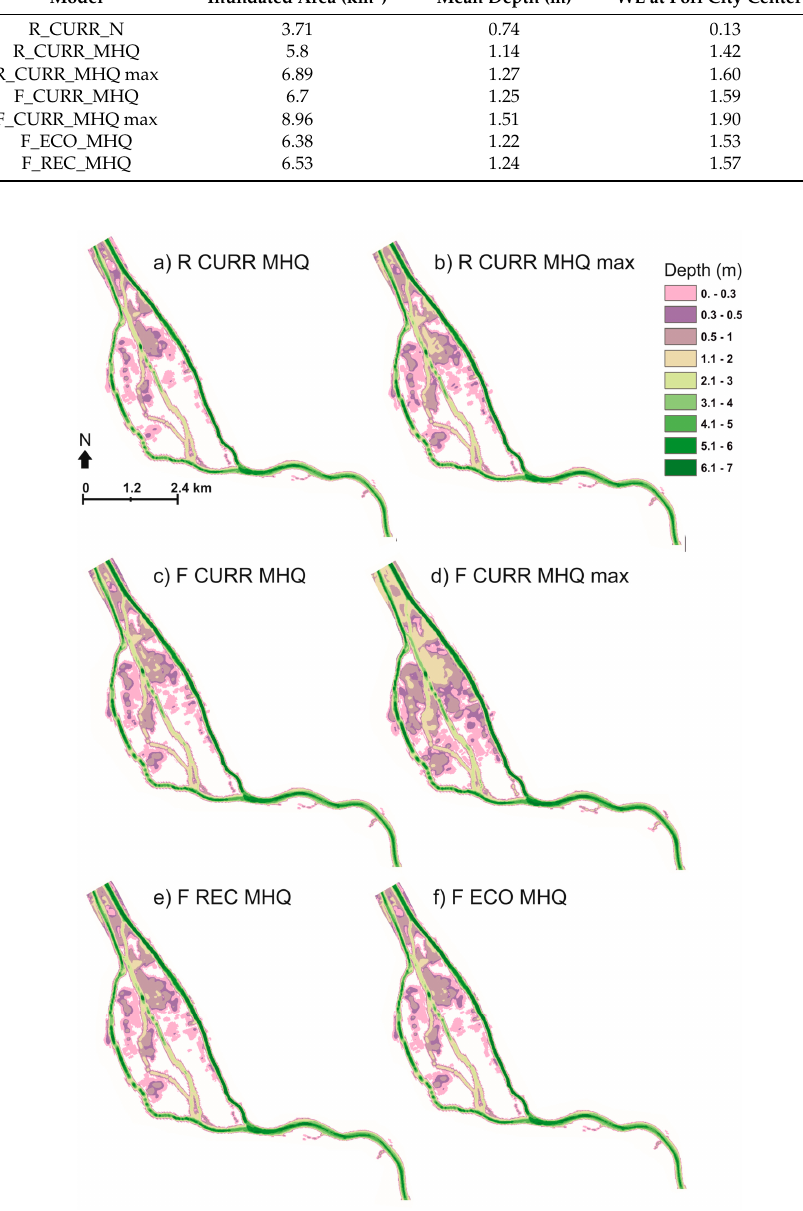
Figure 6. Flow depth during high flow events in the control period ( a , b ) and in the climate change period ( c – f ) with: ( a ) MHQ discharge, current regulation rules, and an average water level (R CURR MHQ); ( b ) MHQ discharge, current regulation rules, and the maximum water level (R CURR MHQ max); ( c ) MHQ discharge, current regulation rules, and an average water level (F CURR